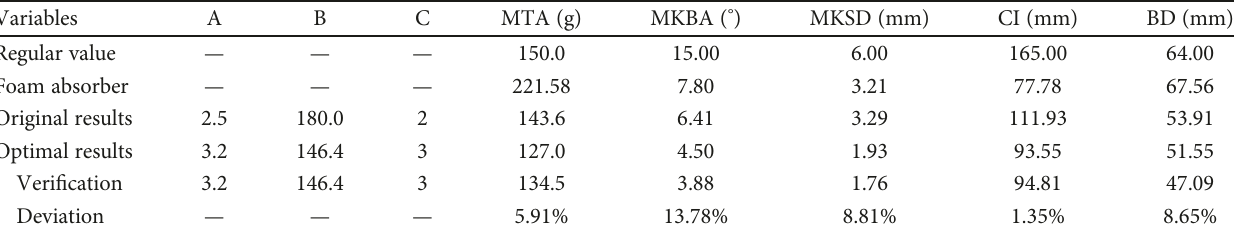
Table 3: Multiobjective optimization results and veri fi